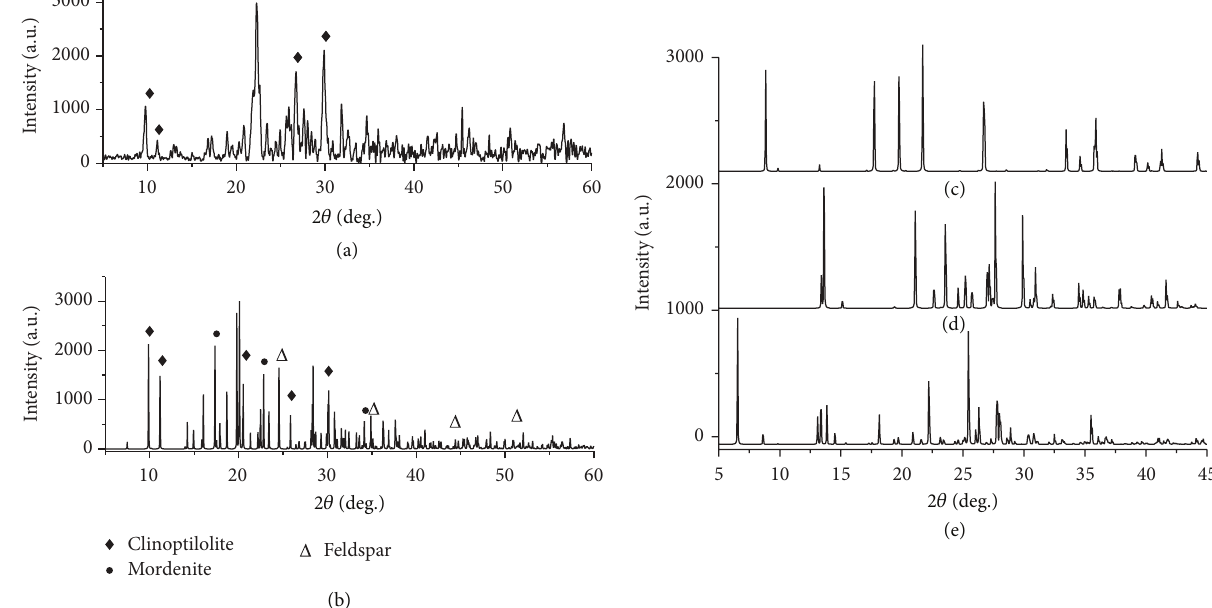
Figure 2: XRD patterns of the natural zeolite obtained (a) experimentally and (b) by simulation of the crystalline phases. (c)–(e) Simulated XRD patterns of the clinoptilolite, mordenite, and feldspar, respectively.